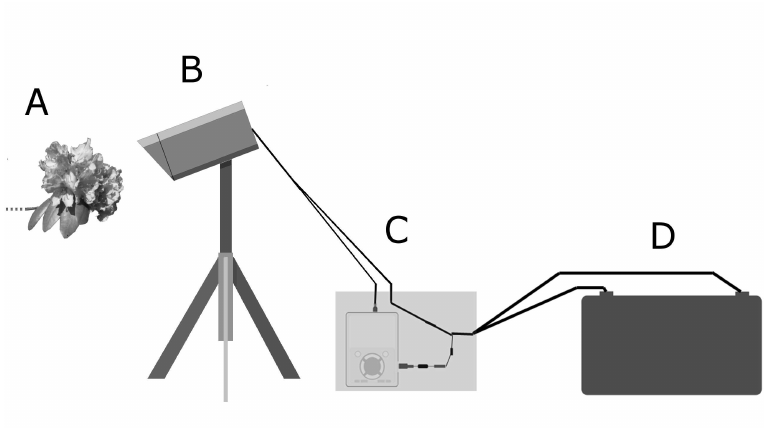
F IG . 1. Schematically drawing of the monitoring system: (A) rhododendron flower stand, (B) colour CCD camera with IR illumination, (C) rainproof plastic box, containing the mini DVR, voltage converter and two fuses, and (D) power supply, 12-volt